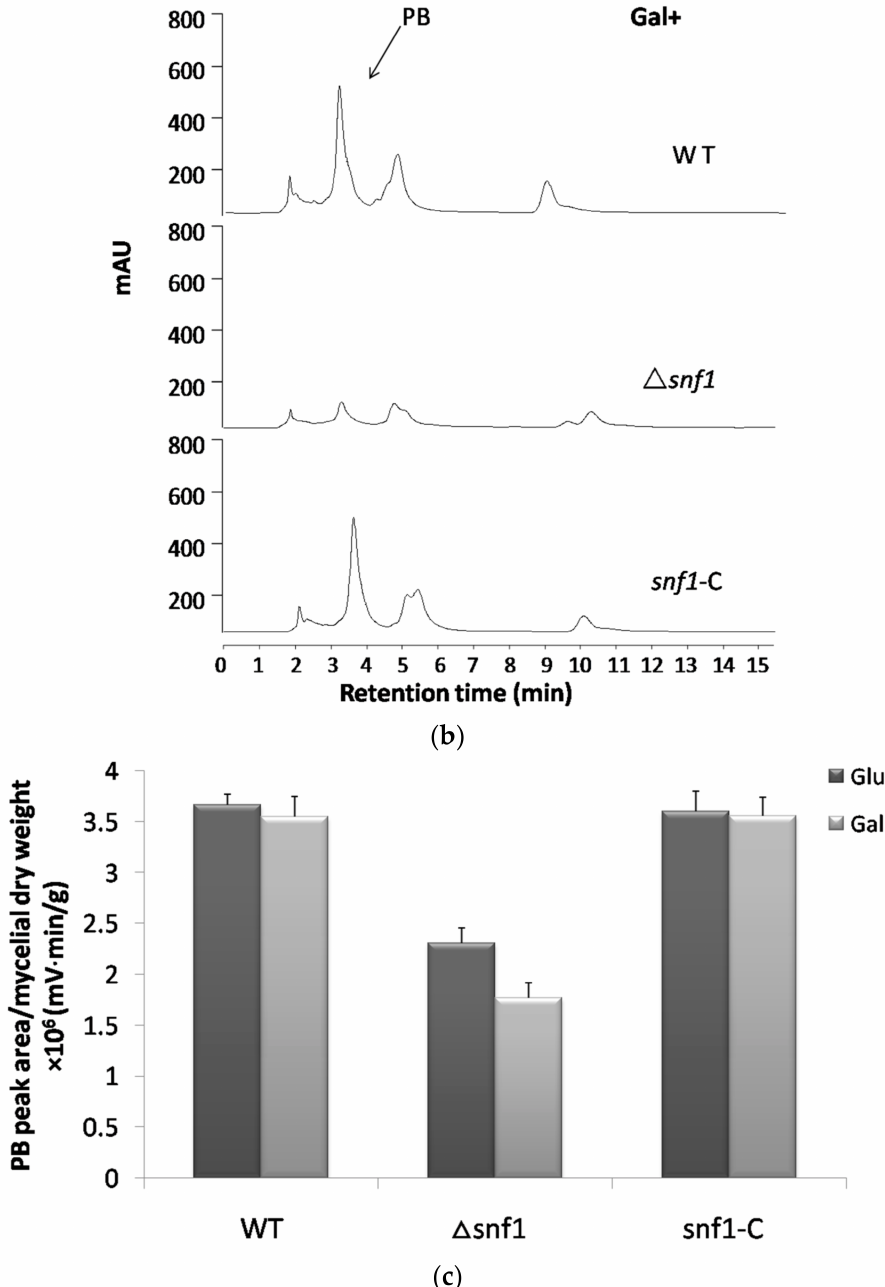
Figure 7. High performance liquid chromatography (HPLC) profiling for secondary metabolites in ∆ snf1 . ( a ) HPLC profiling of the secondary metabolites in ∆ snf1 cultured in PDB. The peak patterns including pestalotiollide B peak of ∆ snf1 was distinct from that of the wild type; ( b ) HPLC profiling of the secondary metabolites in ∆ snf1 in galactose as sole carbon source. HPLC profiling analysis was repeated for three times; ( c ) The ratio of peak area of PB peak relative to the dry weight of mycelium was analyzed. The relative yield of PB in ∆ snf1 significantly decreased comparing with wild-type, especially in the medium of galactose. Error bars represent standard